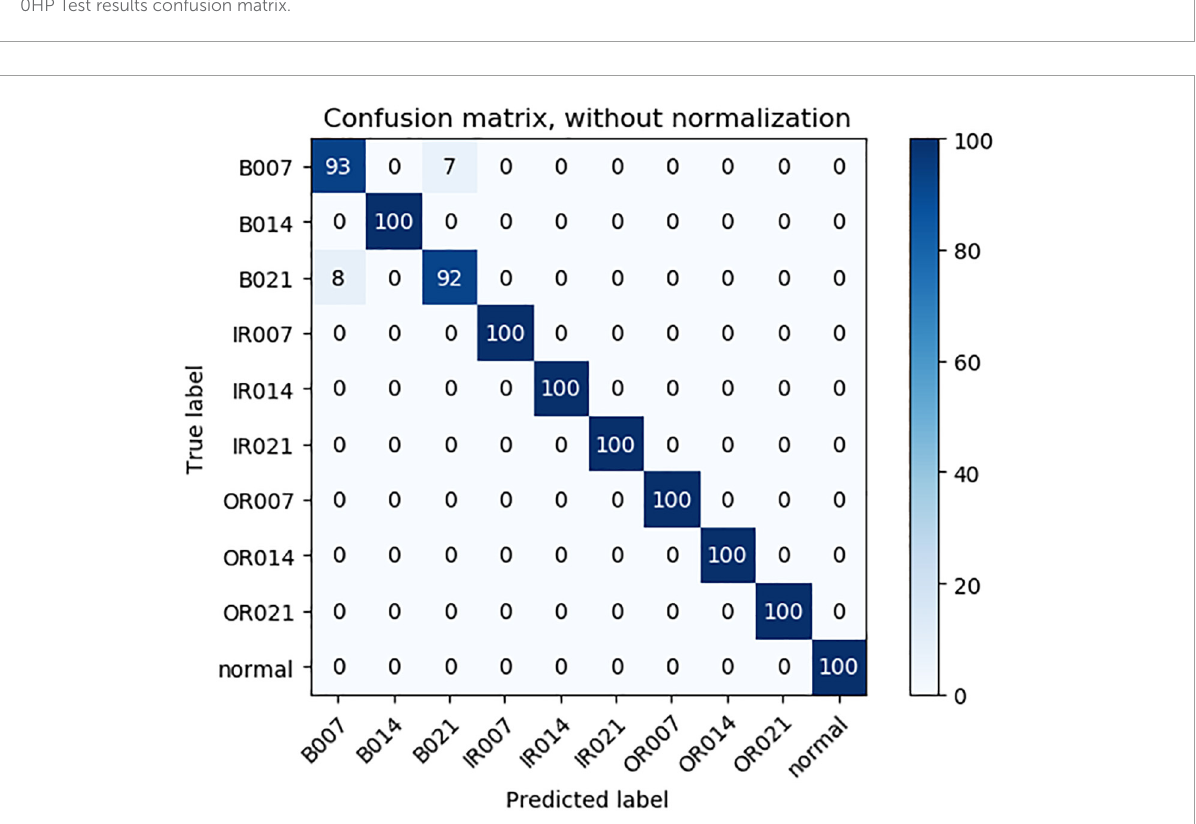
FIGURE5 1HP Test results confusion